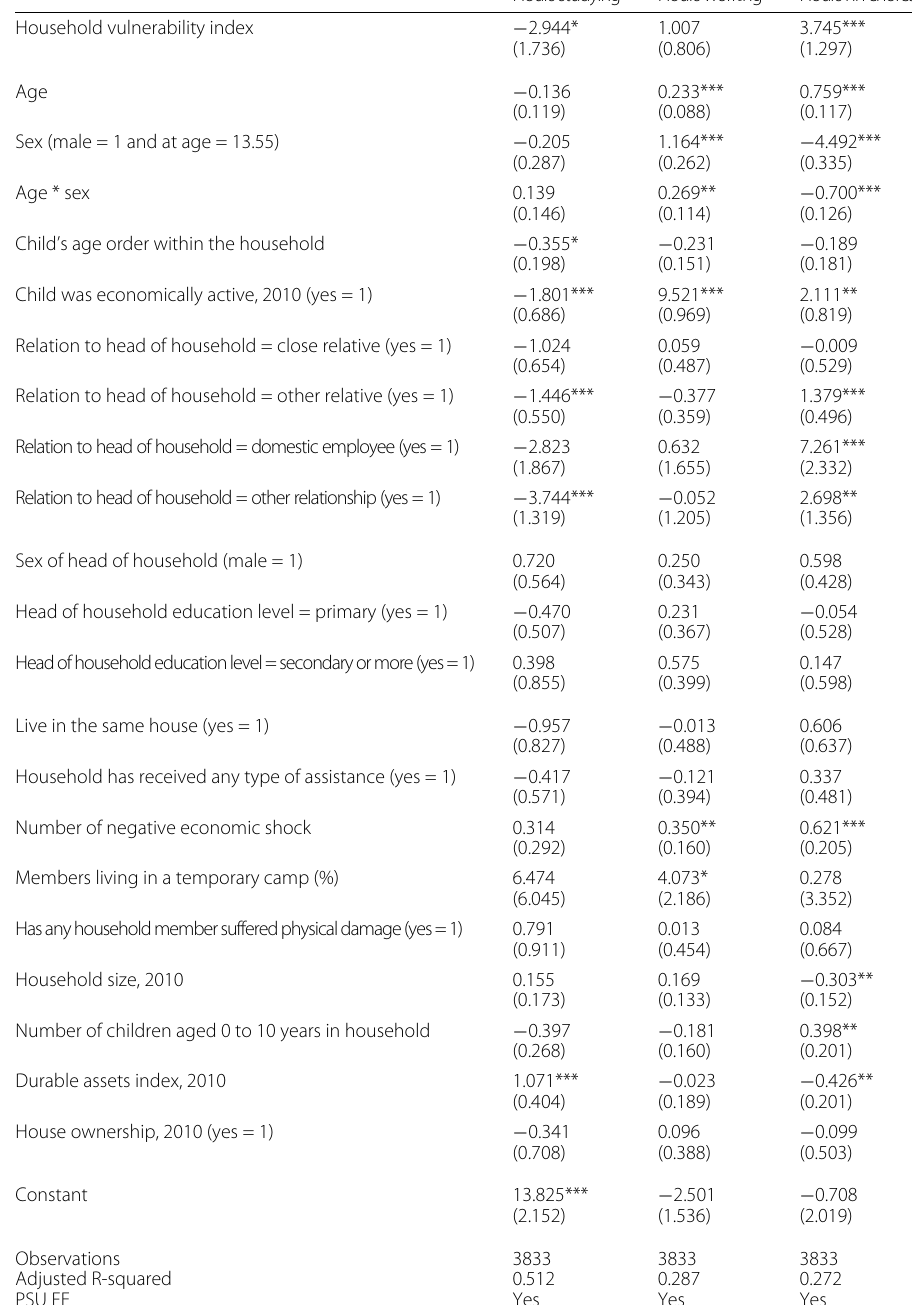
Table 6 Fixed-effects model, number of hours